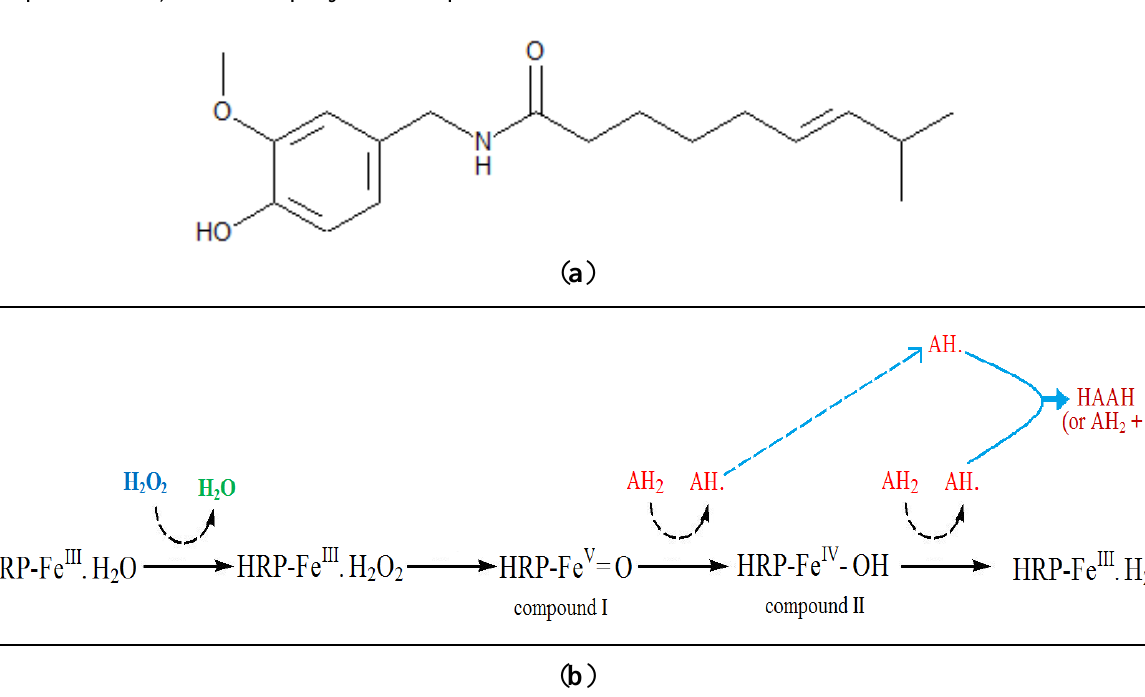
& AH• = molecule & free 2